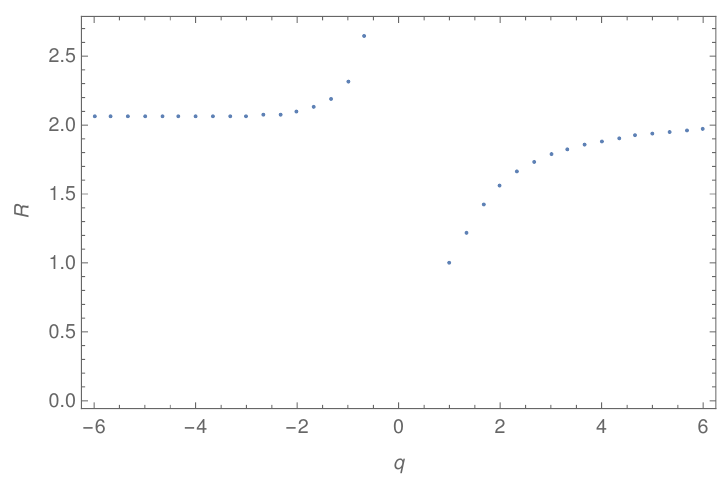
Figure 1 . Recombination factor for the foregoing non-BPS black hole for different values of q .